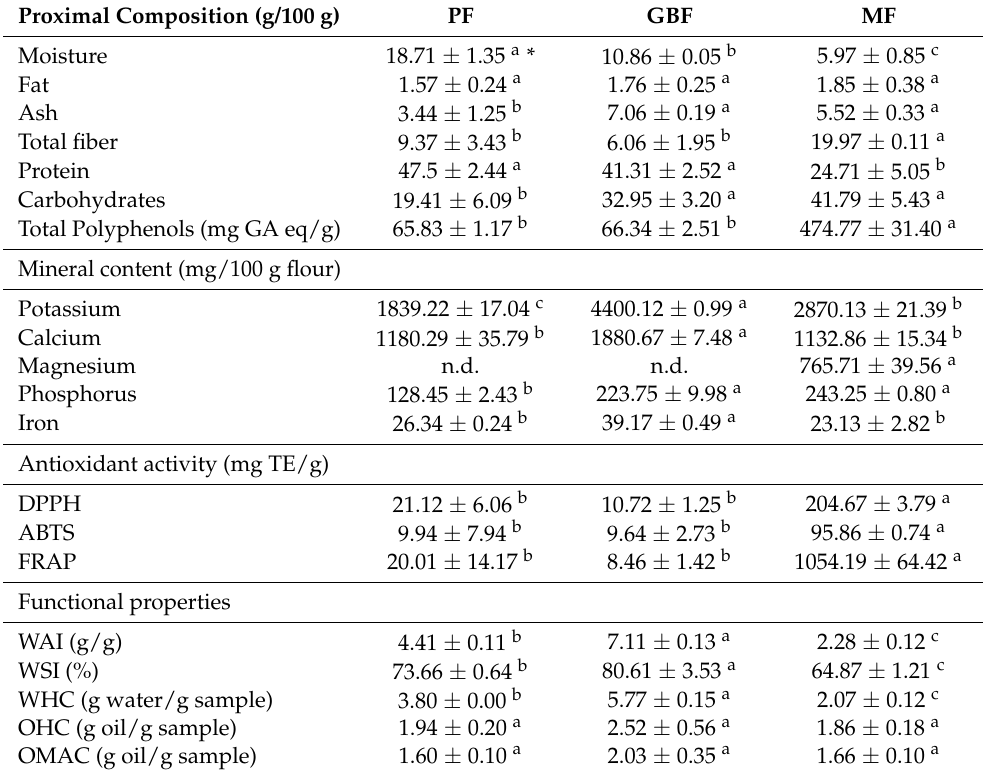
Table 2. Proximal composition, mineral content, and antioxidant and functional activities of the three legume